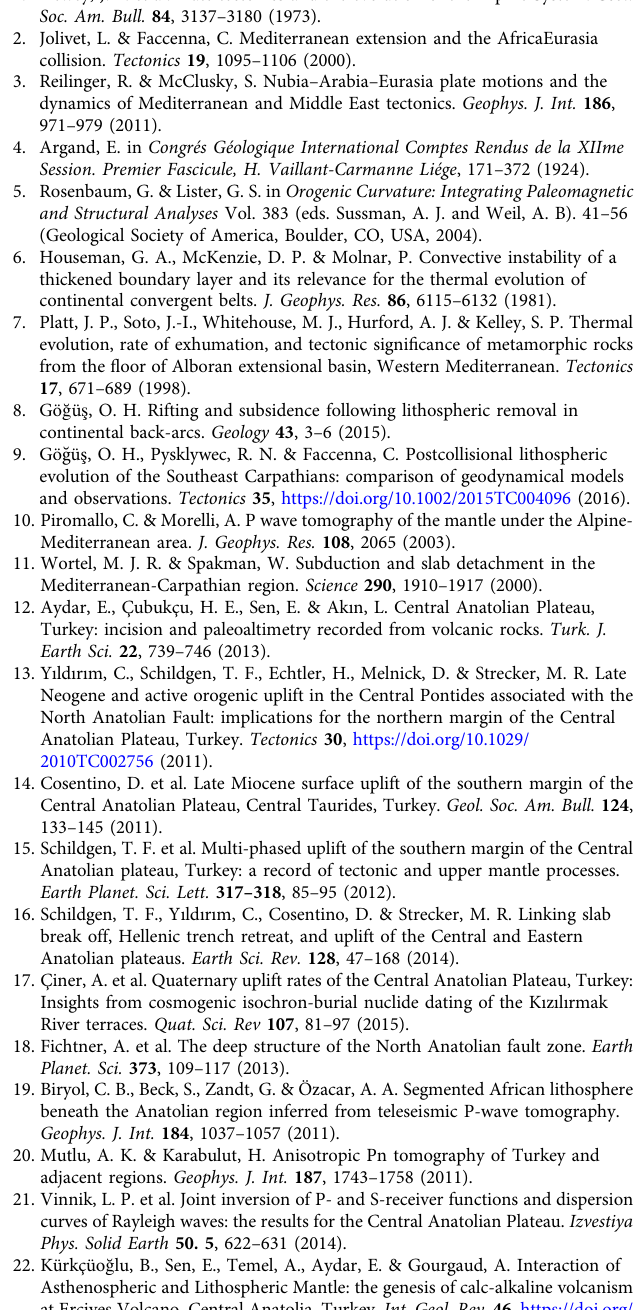
Supplementary Fig. 2. The EXP-1 is associated with lower arc root viscosity which controls the initiation of drip which started at ~10Ma. This timing is and the evolution of surface tectonics is consistent with the geological evolution of